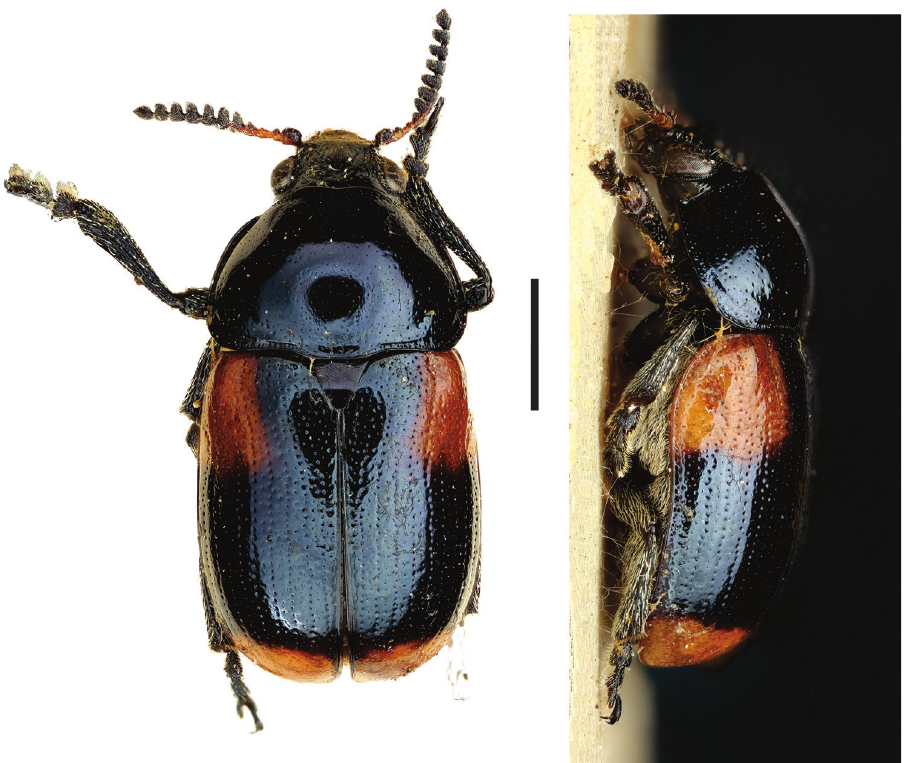
Figure 11. Pnesthes instabilis minuta Monrós (2) , left: habitus (dorsal view), right: habitus (lateral view). Distribution. Two species from Brazil, one of these with a subspecies in North- eastern Argentina which was separated from the typical form by Monrós (1953a) on the basis of its smaller size and distinct punctuation. Argentinian species